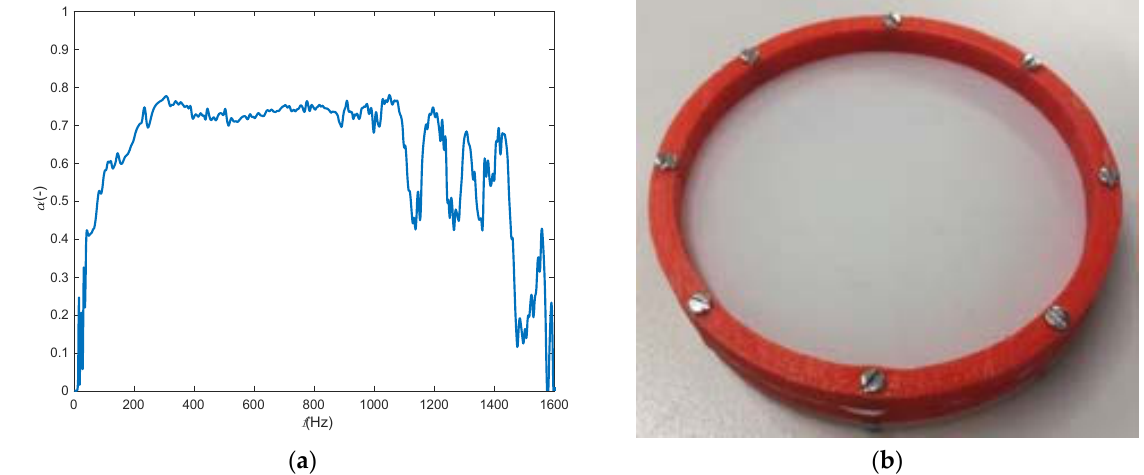
Figure 5. ( a ) The sound absorption coefficient spectra of the muffler measured in accordance to ISO 10534-2; and ( b ) test specimens—a single-leaf 0.5 mm PTFE membrane.